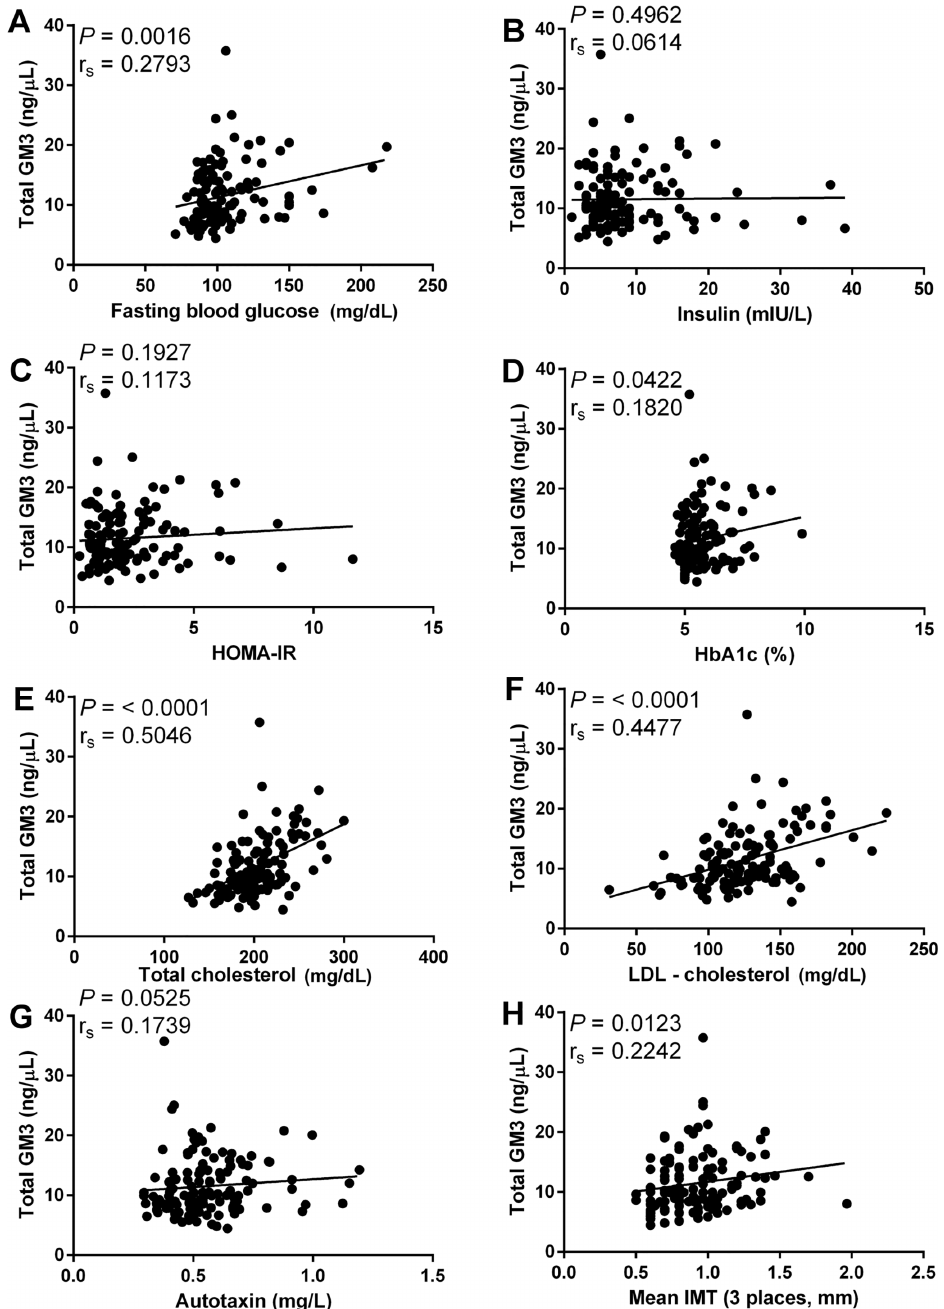
Fig 4. Association between metabolic disease risk factors and total GM3. Correlation of total GM3 with fasting blood glucose (A), insulin (B), HOMA-IR (C), HbA1c (D), total cholesterol (E), LDL-c (F), autotaxin (G) and mean IMT (H). Spearman ’ s rank correlation was used to access correlation between total GM3 and metabolic disease risk factors. Correlations of fasting blood glucose, HbA1c, total cholesterol, LDL-c and mean IMT with total GM3 were deemed significant with P values below